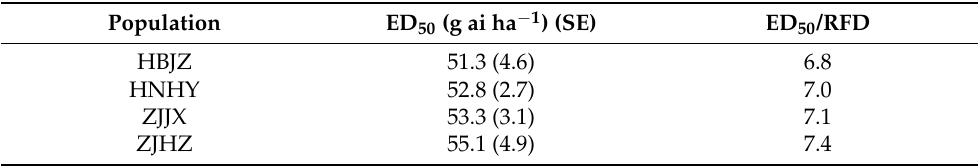
Table 1. The herbicide dose required for 50% fresh weight reduction (ED 50 ) and the ED 50